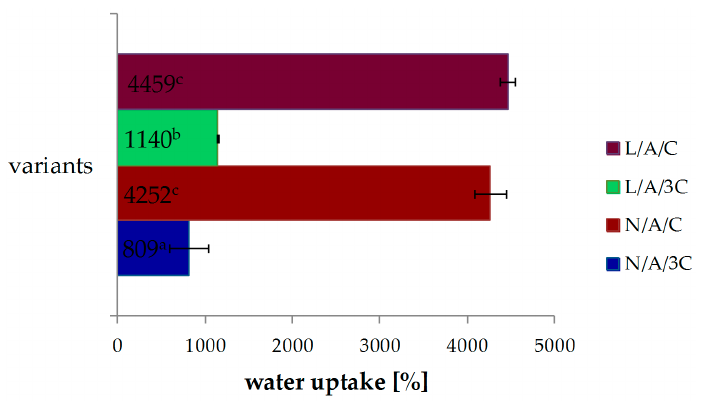
Figure 2. Effect of various sponges’ compositions on swelling ability; a–c values with different letters within the same column differ significantly ( p < 0.05).